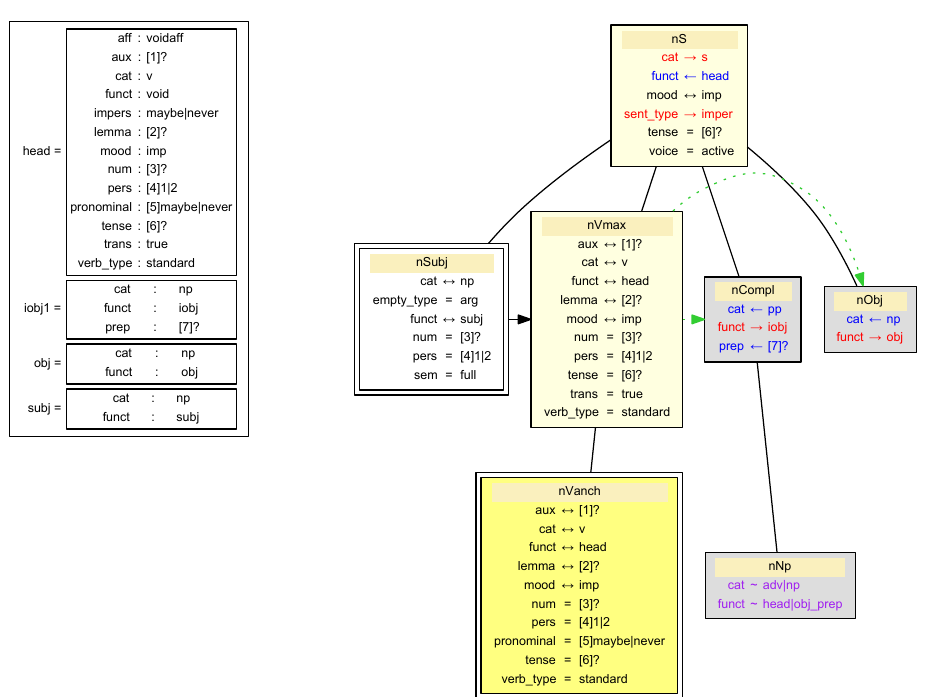
Figure 12: One of the EPTDs generated by the NP0_V_NP1_PP2